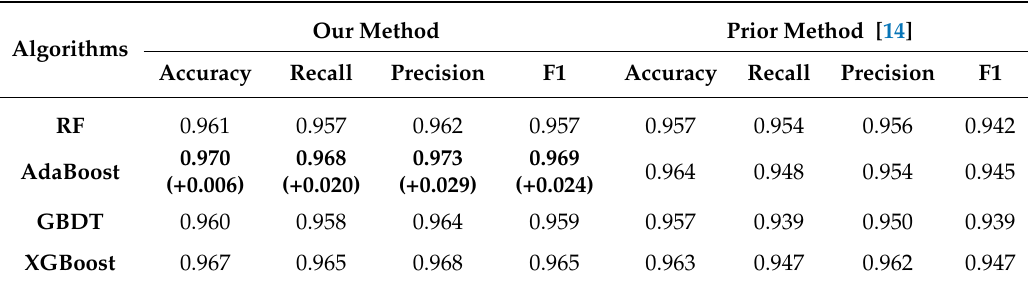
Table 8. Results of step identification within action on the WeChat